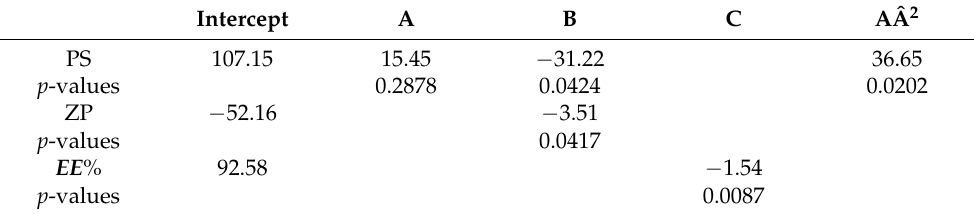
Table 5. Coefficient table for the effect of independent variables on dependent variables.